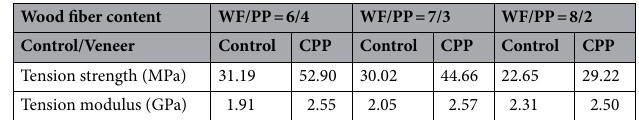
Table 4. Tension properties of WF/PP composite board.